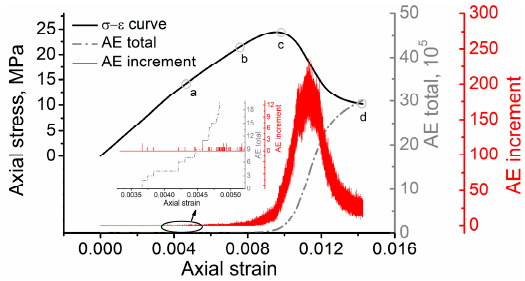
Figure 6. Stress-strain curve combined with simulated acoustic emission pulses.